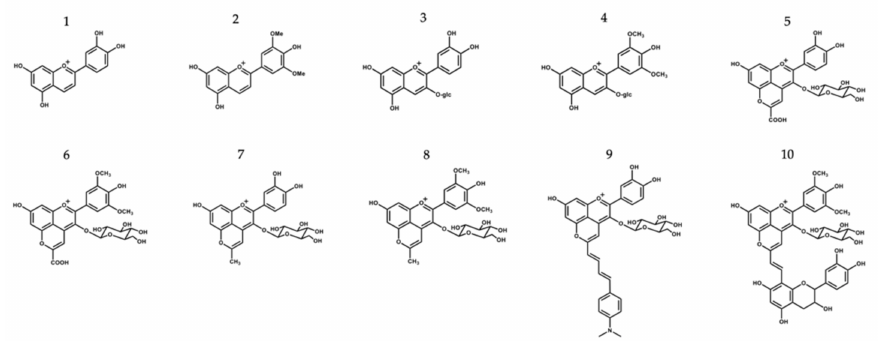
Figure 1. Chemical structure compounds (deoxyanthocyanins, anthocyanins and its related struc- tures) selected for this study: 1—Luteolinidin (Lut); 2—Deoxymalvidin (DeoxyMv); 3—Cyanidin- 3- O -glucoside (Cy-3-glc); 4—Malvidin-3- O -glucoside (Mv-3-glc); 5—Carboxypyranocyanidin-3- O - glucoside (CarboxypyCy-3-glc); 6—Carboxypyranomalvidin-3- O -glucoside (CarboxypyMv-3-glc); 7— Methylpyranocyanidin-3- O -glucoside (MethylpyCy-3-glc); 8—Methylpyranomalvidin-3- O -glucoside (MethylpyMv-3-glc); 9—4-(Dimethylamino)-cinnamyl-10-butadienylidene-pyranocyanidin-3- O - glucoside (Dimethylamino-cin-but-pyCy-3-glc); 10—Vinylpyranomalvidin-3- O -glucoside-catechin